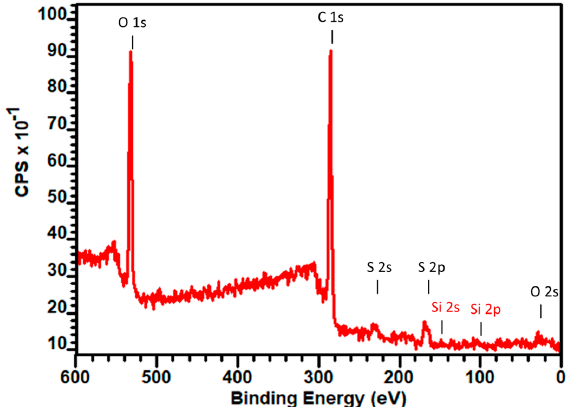
Figure 3. The XPS survey data, with locations of relevant 1s, 2s, and 2p (triplet) peaks indicated. The peaks for oxygen, carbon, and sulfur, prominent in PEDOT:PSS, are indicated in black. No silicon peaks are discernable, indicating the complete or near-complete coverage of the surface by the PEDOT:PSS layer.